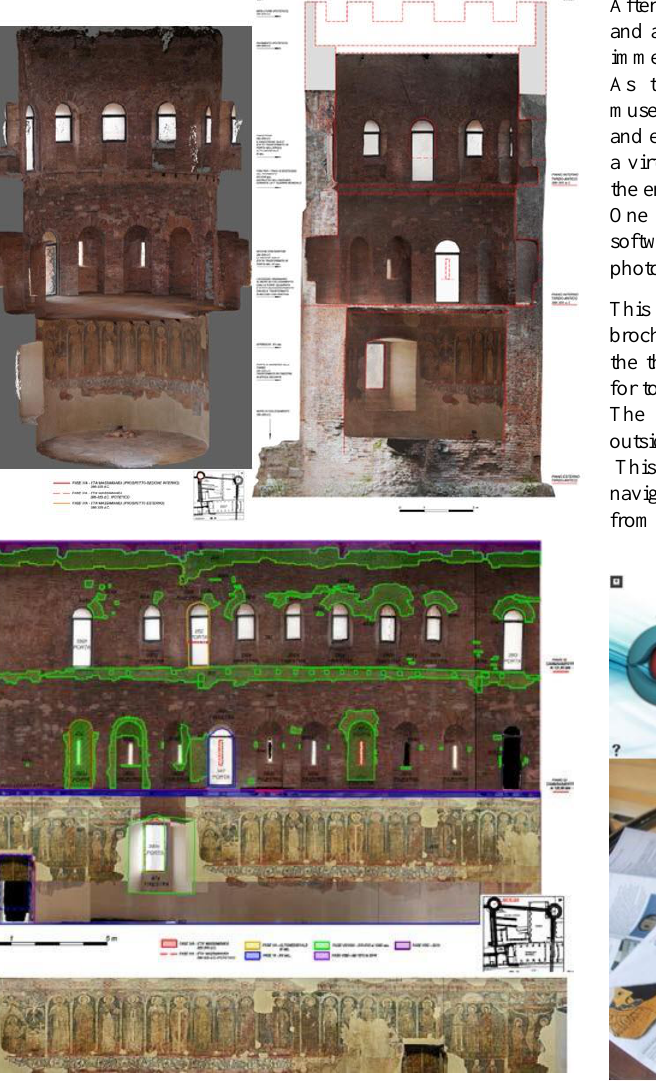
Figure 8. 3D model from digital photogrammetry: the polygonal tower sectioned E-W and prospects with interpretation